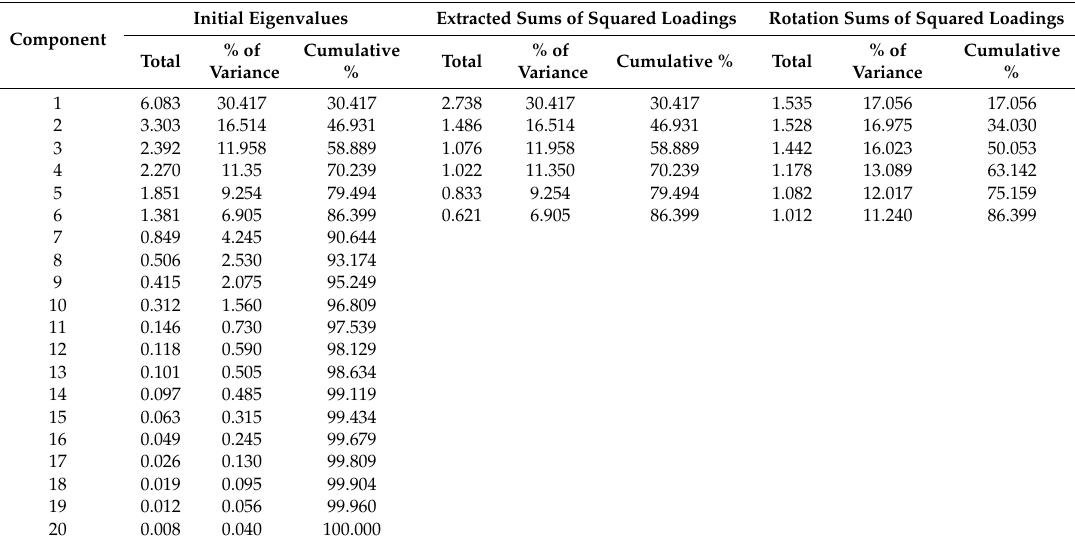
Table 6. Principal component of factor analysis.